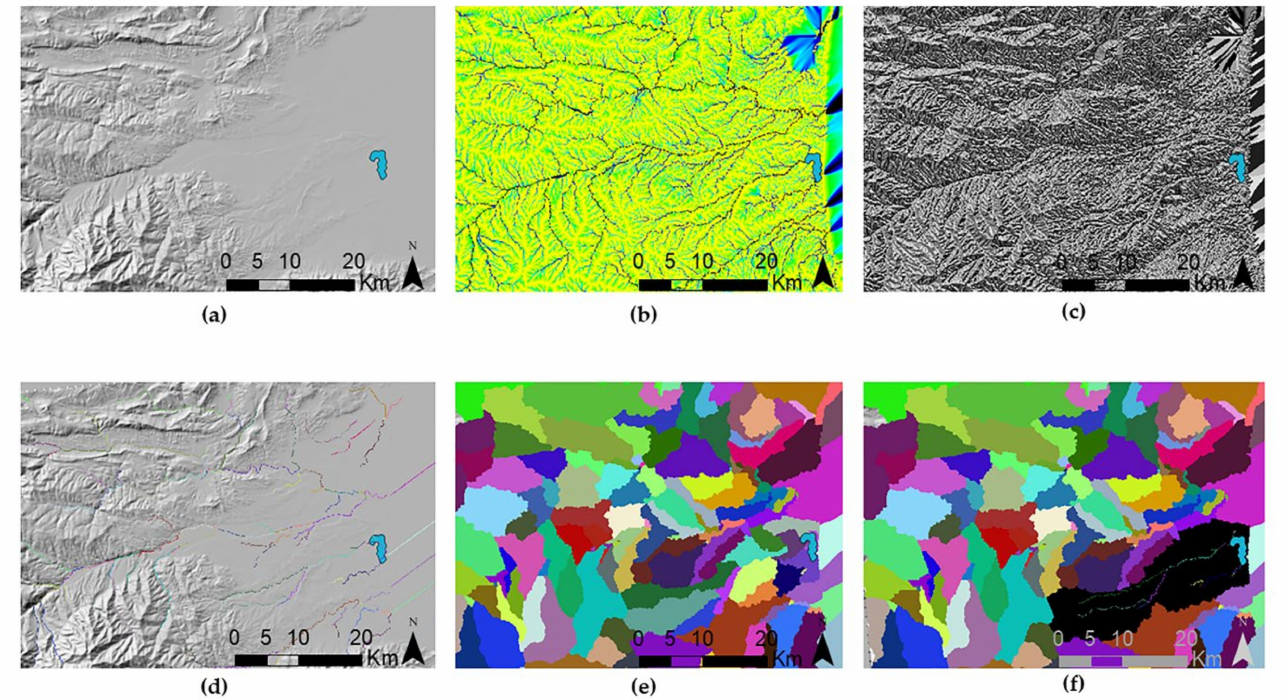
Figure 2. Steps followed for the delineation of the catchment area of the 11 studied coastal lagoons in Geographic Resources Analysis Support System (GRASS) Q-GIS, with the example of CANE (Etangs de Canet et de Villeneuve-de-la-Raho waterbody): ( a ) Digital Elevation Model (DEM) and coastal lagoon delineation; ( b ) flow accumulation map; ( c ) drainage direction map; ( d ) streams map; ( e ) sub-catchments map (minimum 2000 pixels per sub-catchments); ( f ) integration of sub-catchments and total catchment (in